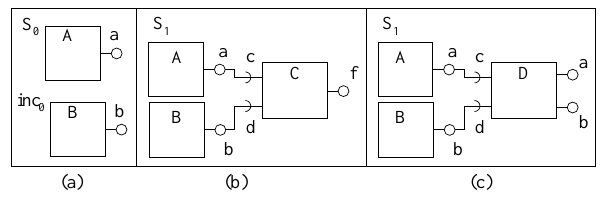
Figure 19. Components with provided ports only: ( a ) Components, ( b ) First system, and ( c ) Second system.